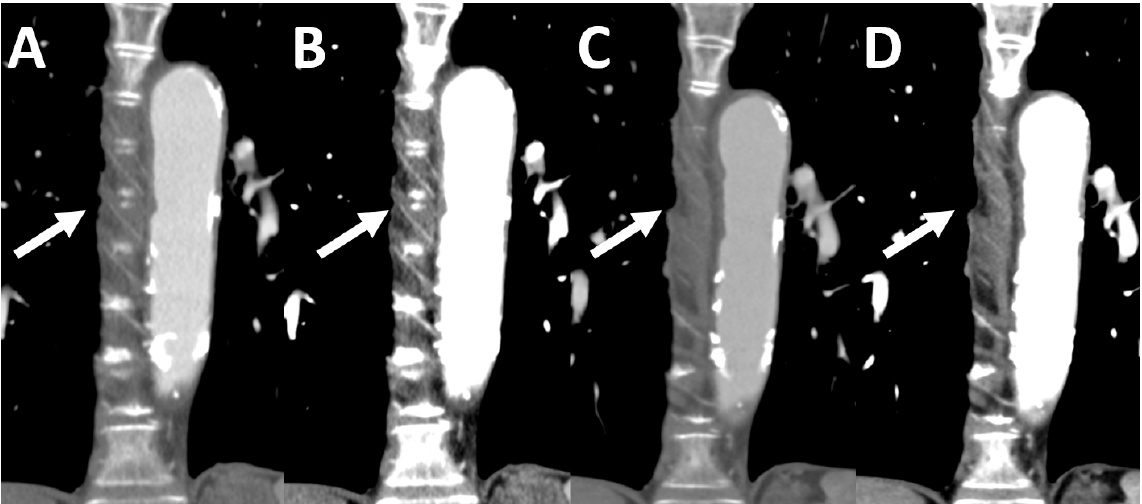
Figure 4. Delineation of mediastinal vessel contours in a 63-year-old man. Window width: 342 HU, window level: 56 HU ( A ) Q1 iterative reconstructed image data set, ( B ) Q3 iterative reconstructed image data set, ( C ) ADMIRE1 iterative reconstructed image data set. Arrows: thin mediastinal vessel.